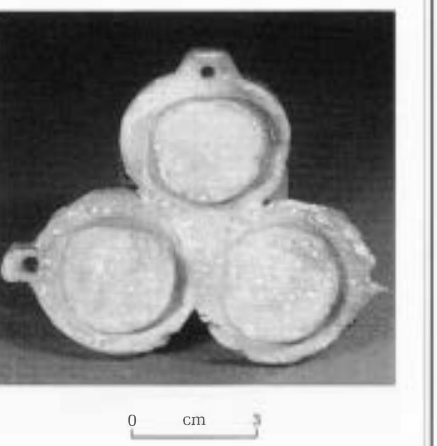
Figure 4 Underside of the wooden lid of the three-lobed